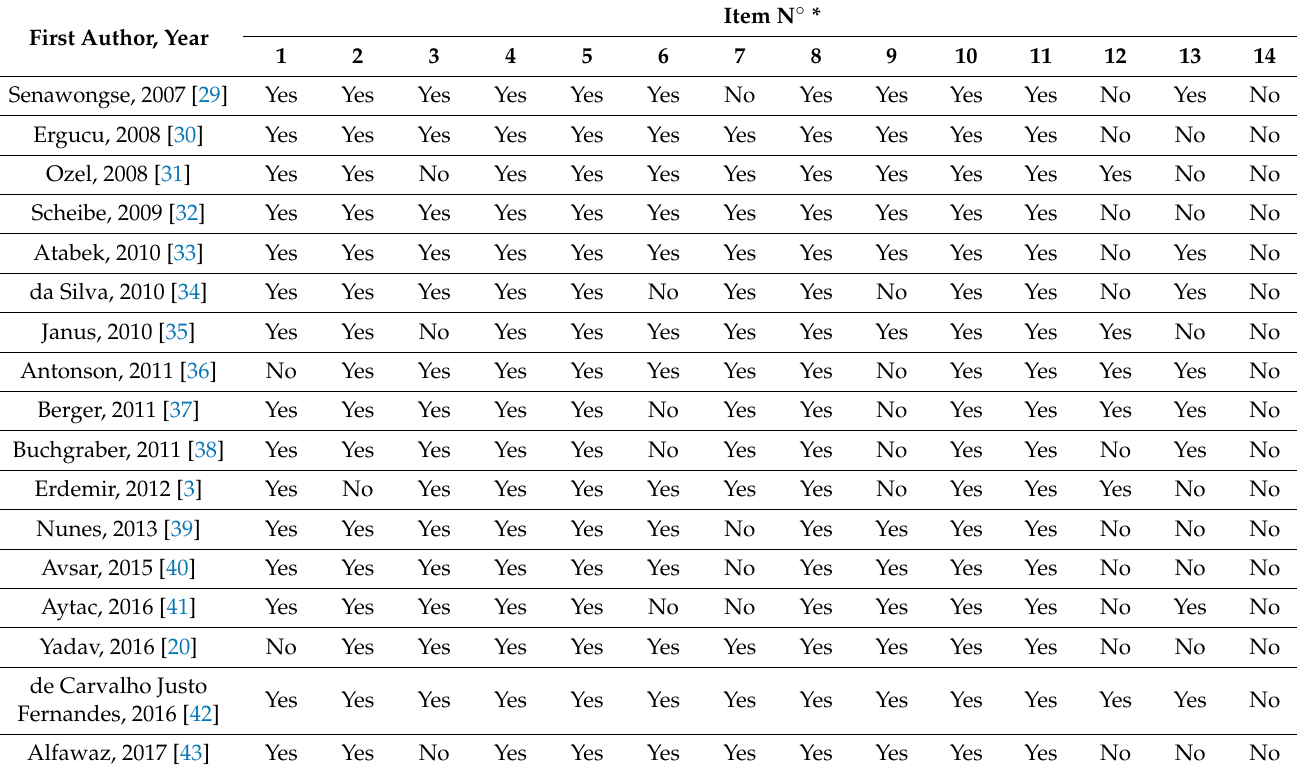
Table 1. Application of guidelines for reporting preclinical in vitro studies on dental materials for the selected studies in the systematic review (n =